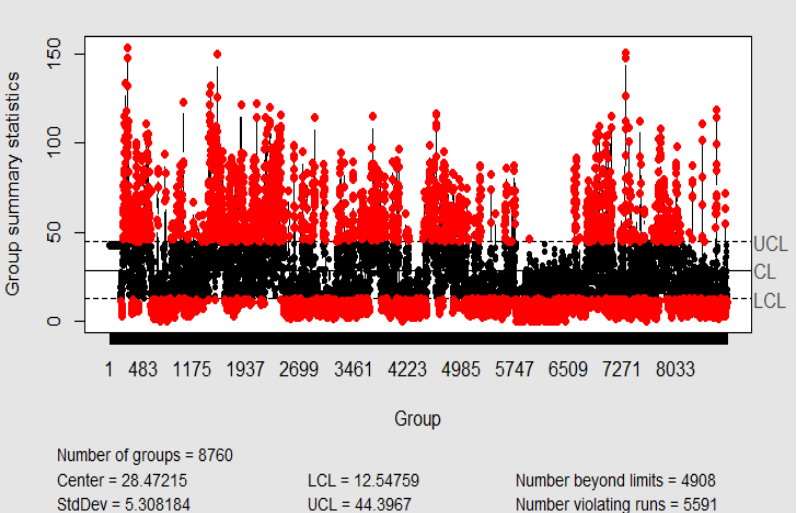
Figure 5. Individual-moving range chart (IMR chart) X/R with mobile range of hourly NO 2 concentrations from Blanchardstown air quality monitoring station. Software: R-programming [56].